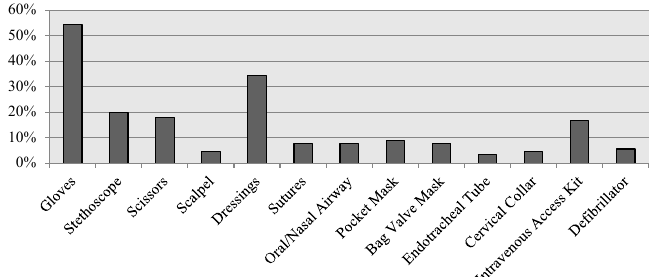
Figure 3 . Supplies considered useful (by survey respondents).